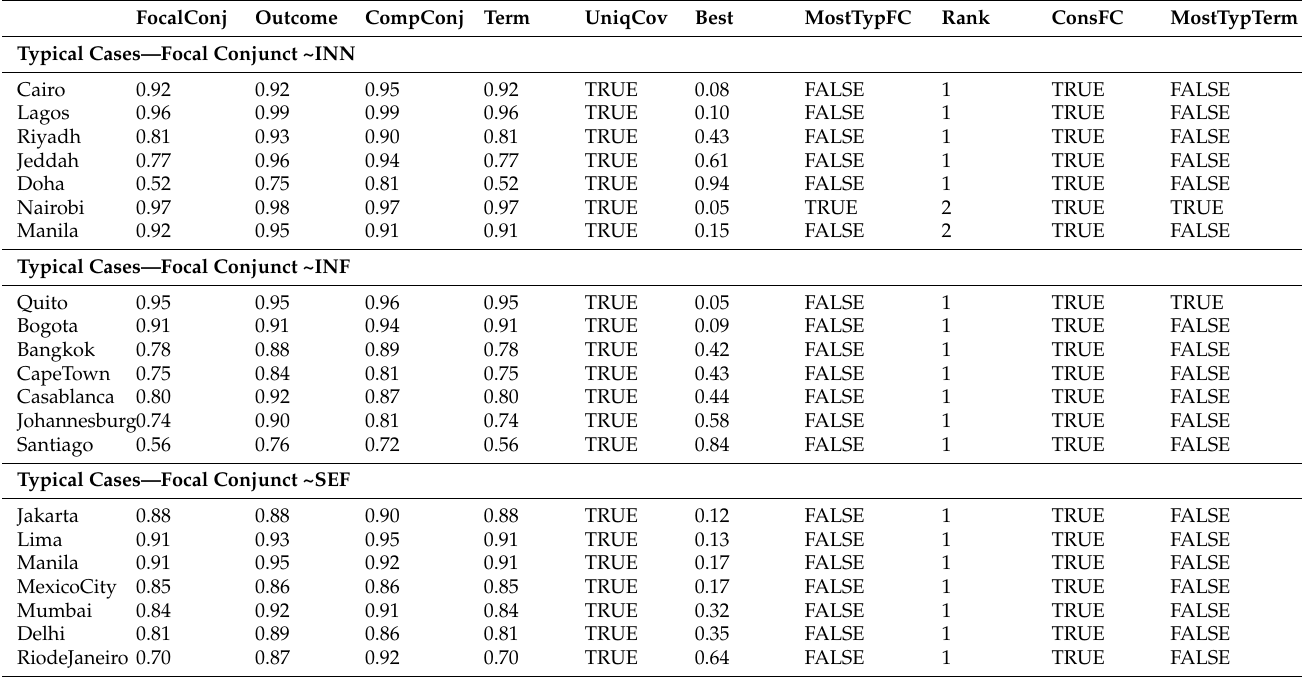
Table 5. Analysis of typical cases for ~OVE.